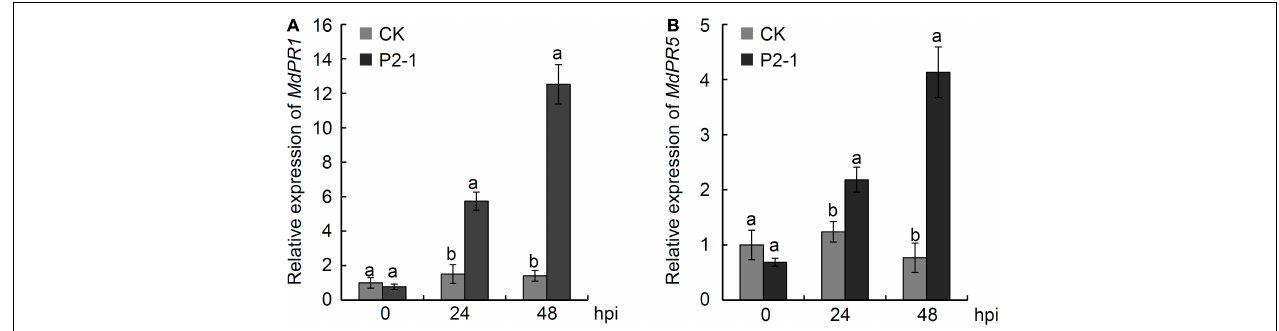
FIGURE 9 | qRT-PCR assay for MdPR1 gene (A) and MdPR5 gene (B) expression in apple fruit induced by B. velezensis strain P2-1. Each data represents the mean ± SD of three biological replicates at each time point. Different letters indicate significant differences between different treatments according to Student’s t -test ( P <